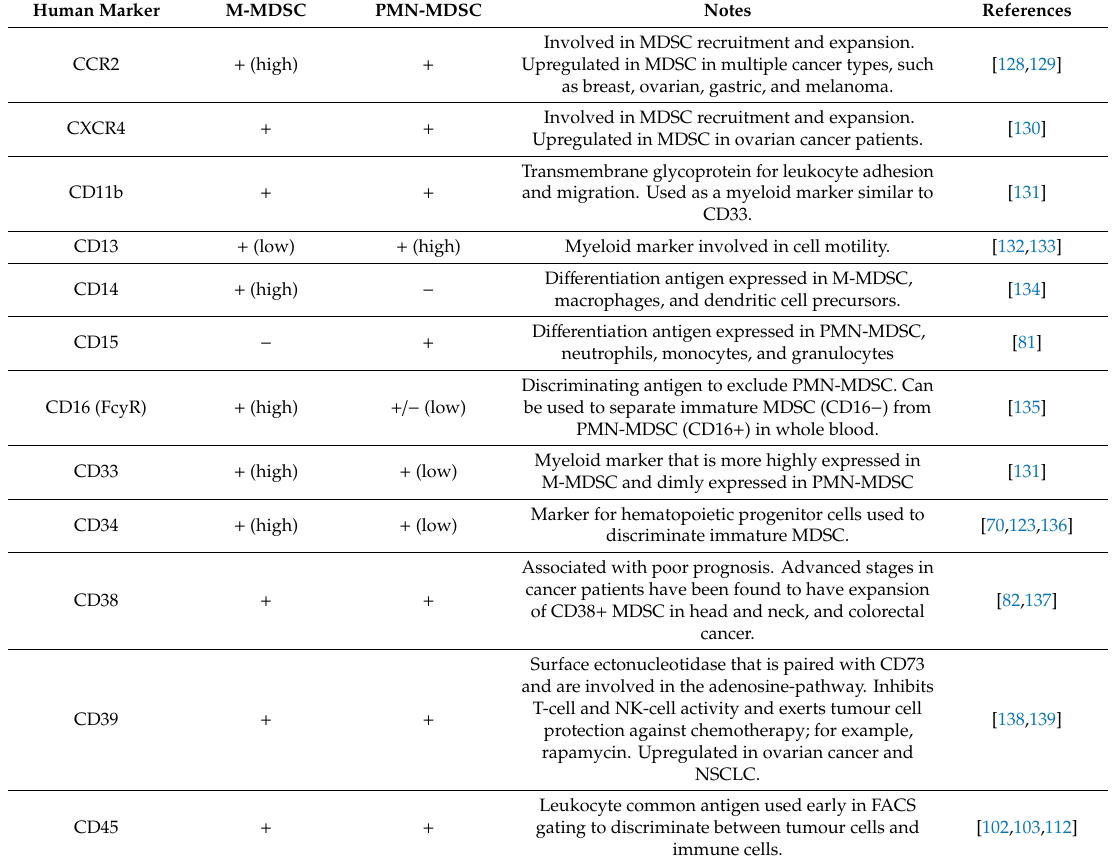
Table 2. Markers used to identify MDSC populations and functions